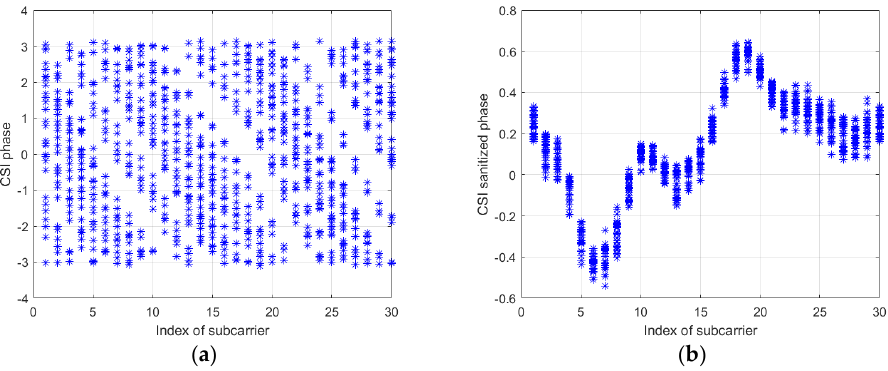
Figure 1. Comparison of ( a ) the Channel State Information (CSI) raw phases with ( b ) sanitized phases.